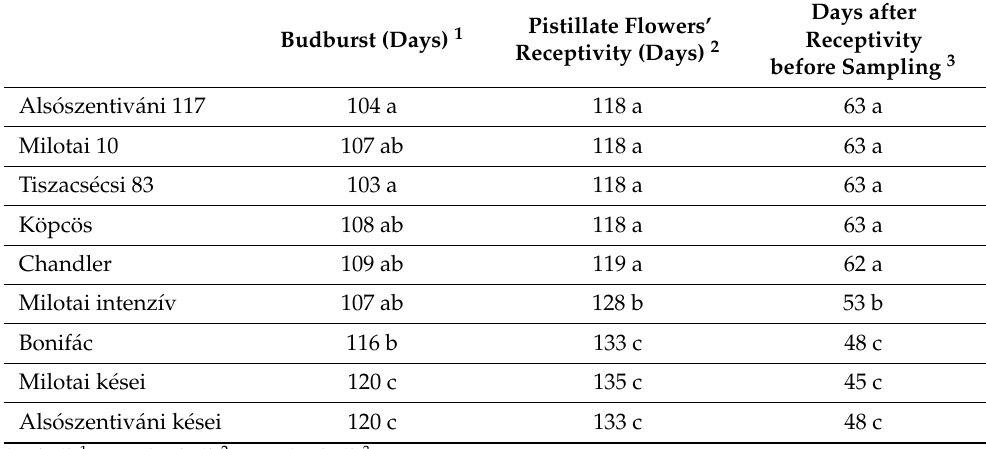
Table 4. The time of budburst and pistillate flowers’ receptivity in calendar days starting from 1